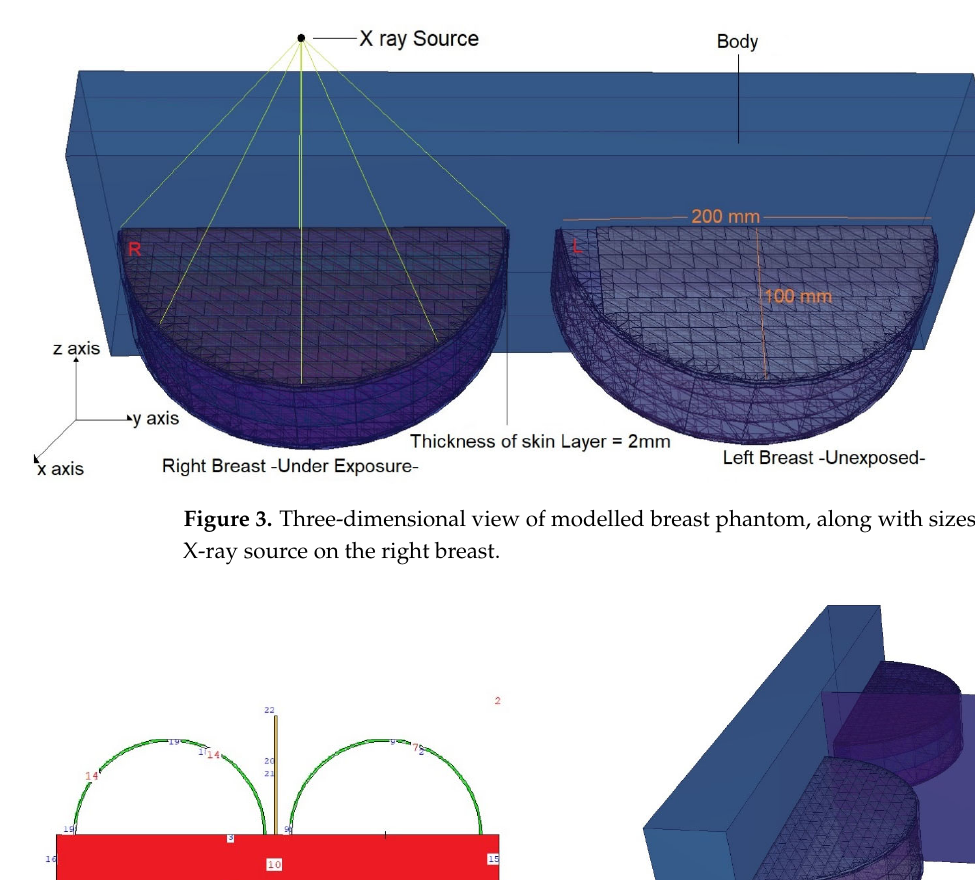
Figure 3. Three ‐ dimensional view of modelled breast phantom, along with sizes and the location of X ‐ ray source on the right breast.